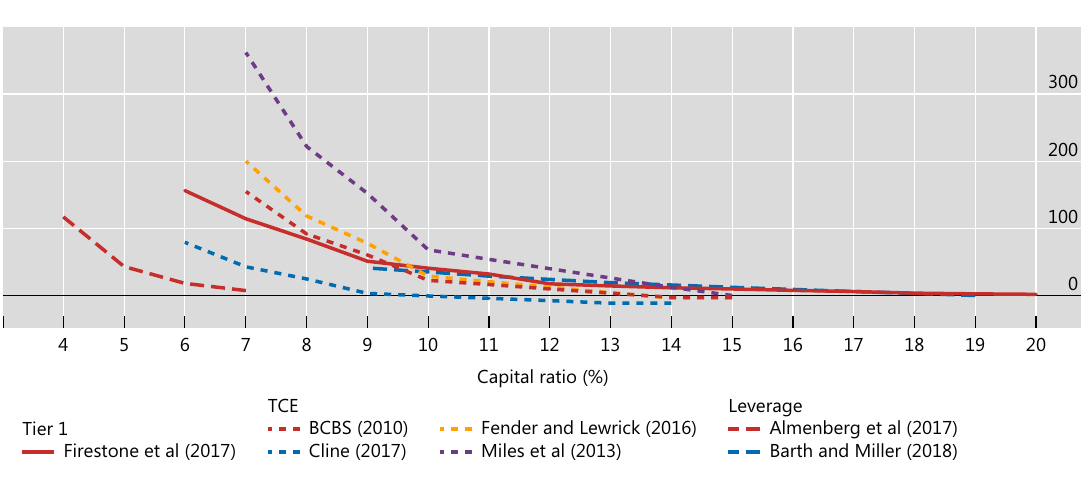
Figure 9. Net marginal benefit (discounted, annual GDP basis points).